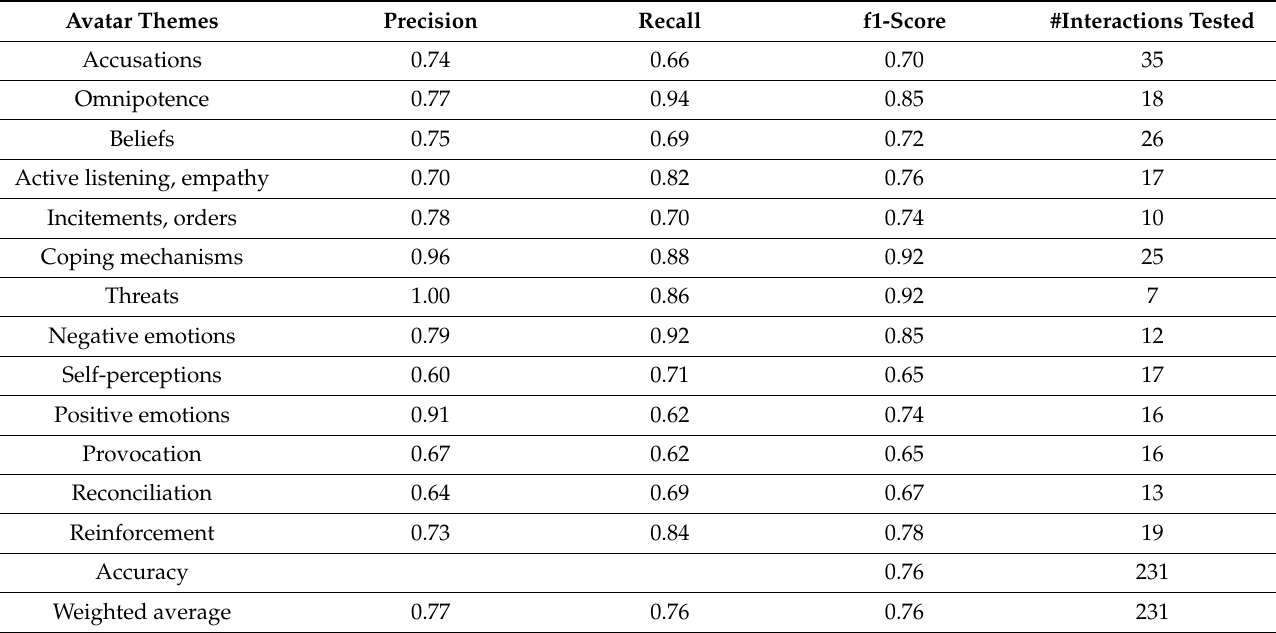
Table 3. Classification performances for the automated annotation of the AT